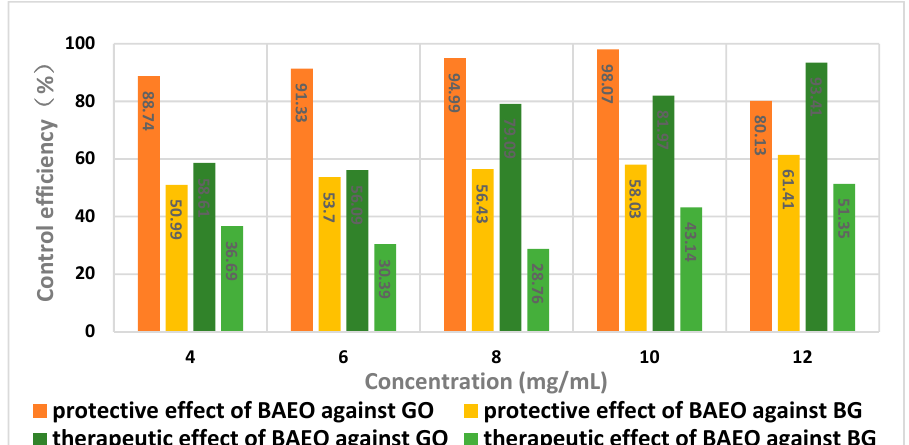
Figure 5. Protective and therapeutic efficacy of BAEO against Gloeosporium orbiculare (GO) and Blumeria graminis (BG). Table 6. Screening the protective effect of BAEO against Gloeosporium orbiculare